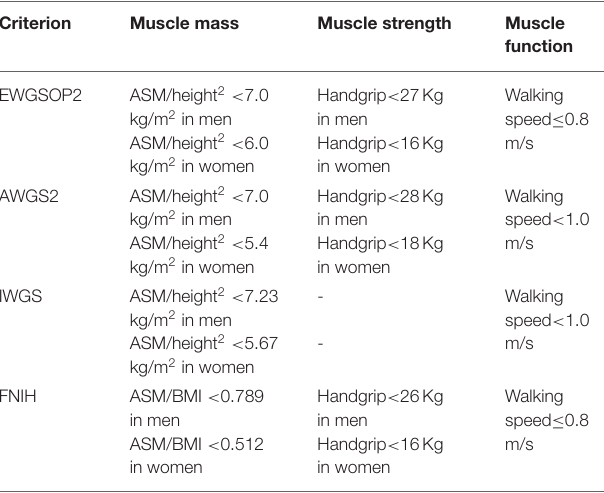
TABLE 1 | The specific latest diagnostic criteria for sarcopenia.